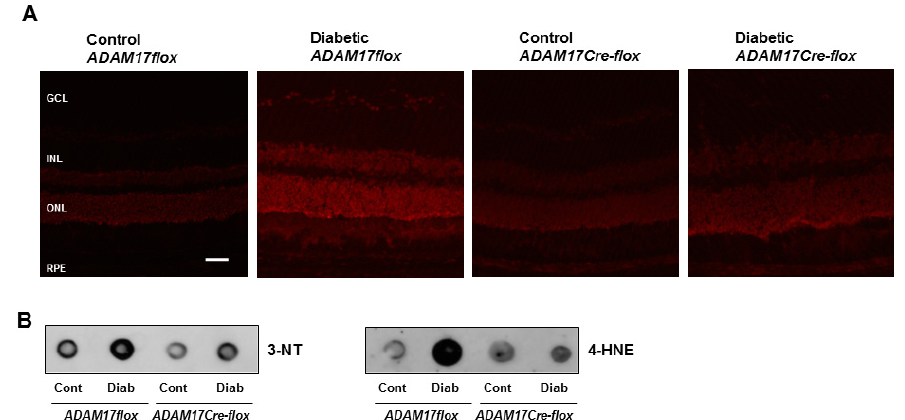
Figure 5. Diabetes-induced oxidative stress is decreased in mice with conditional inactivation of endothelial ADAM17. ( A ) Representative images of DHE-stained retinal sections from control normoglycemic and diabetic ADAM17flox and ADAM17Cre-flox mice. n = 3. Scale bar: 50 µ m. ( B ) Dot blot analysis of 4-HNE and 3-NT in retinal tissue from control normoglycemic and diabetic ADAM17flox and ADAM17Cre-flox mice. Cont, control; Diab, diabetic. n = 3.